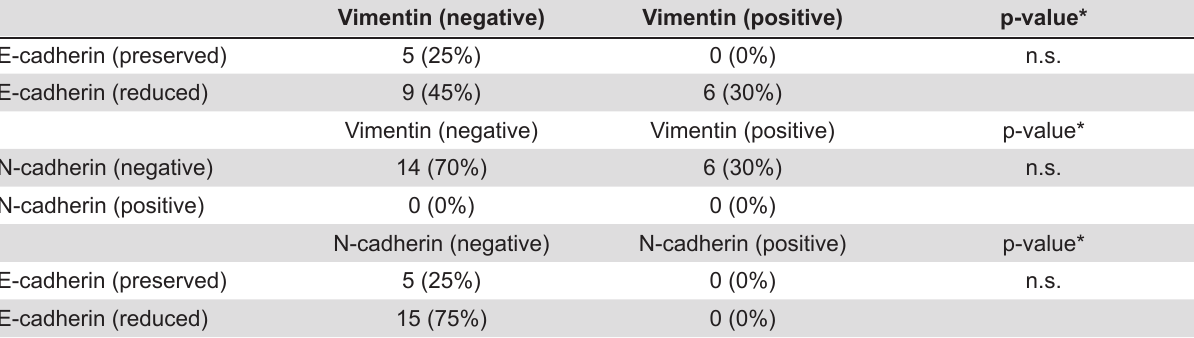
Table 3- E-cadherin, N-cadherin and vimentin expression at the invasive front (IF) of oral squamous cell